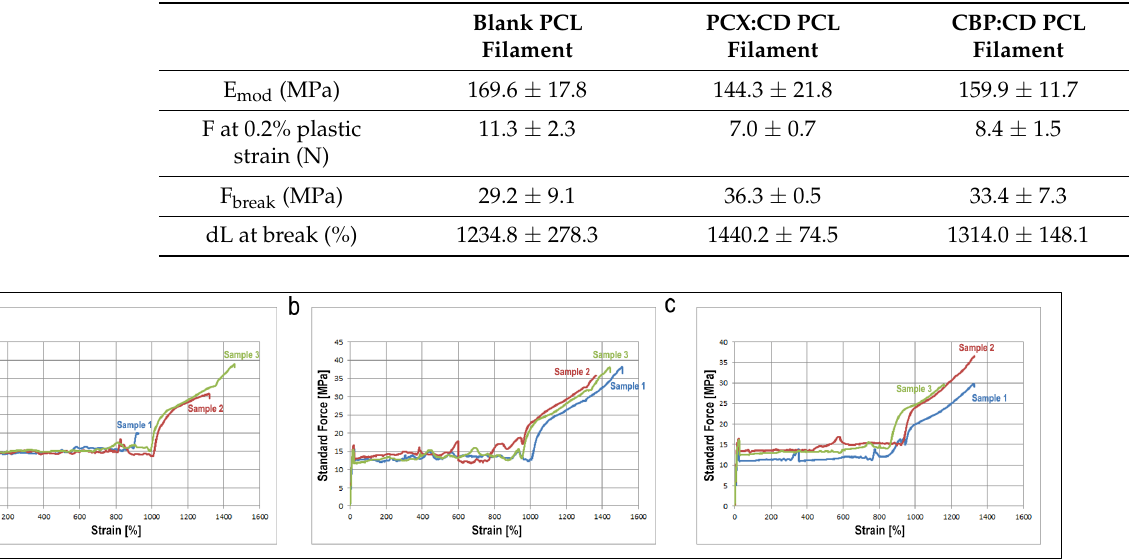
Figure 7. Stress/Strain graph of ( a ) Blank PCL Filament, ( b ) PCX:CD PCL Filament, ( c ) CBP:CD PCL Filament ( n = 3, sample 1 (blue), sample 2 (red), sample 3 (green)). Table 2. Mechanical properties data of blank and drug-loaded fi laments ( n = 3).